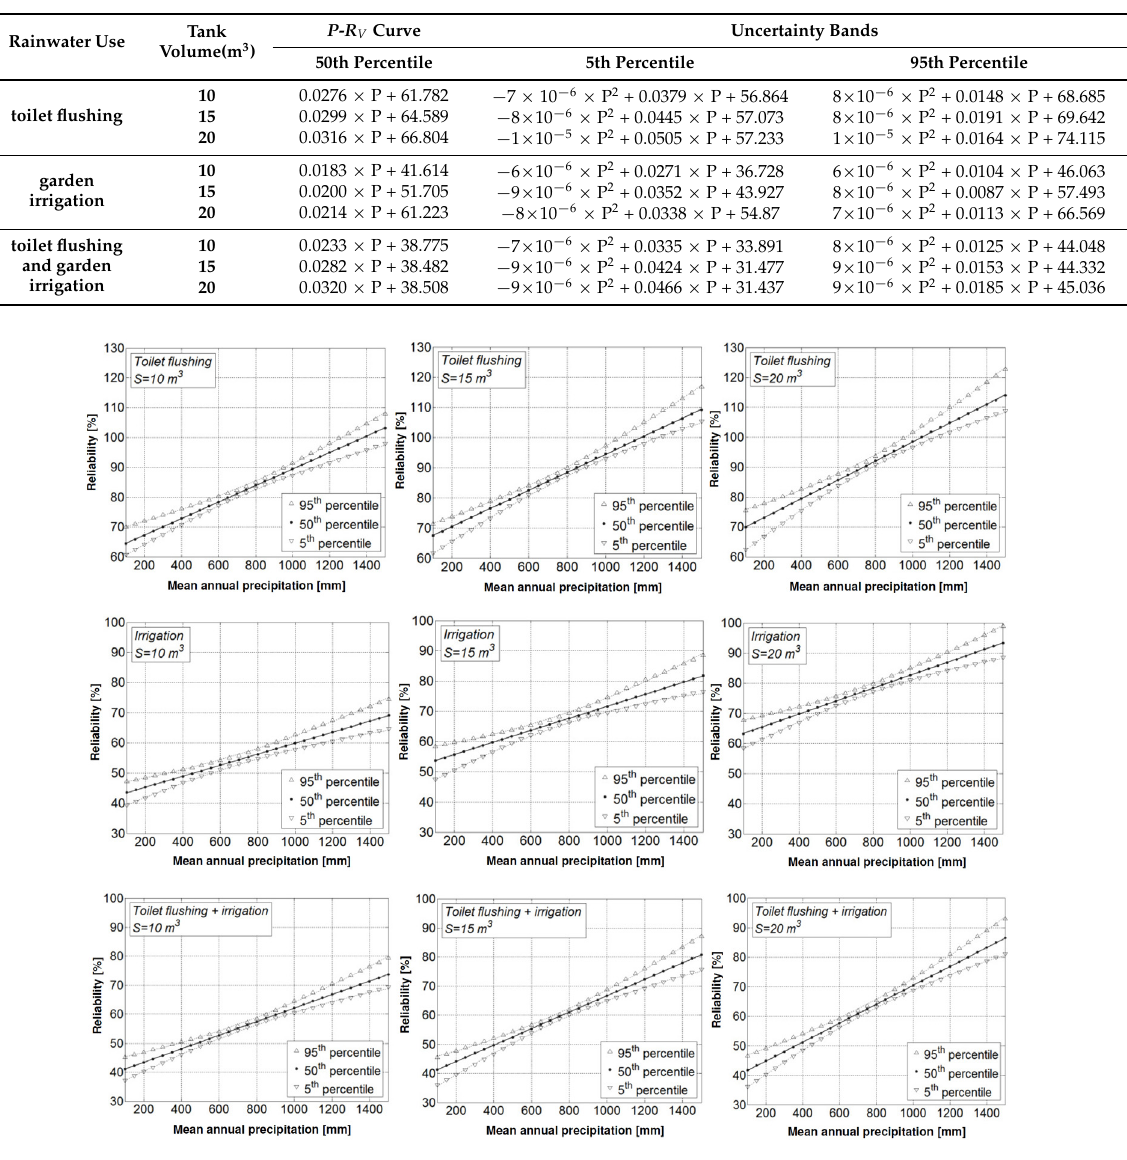
Figure 7. Reliability curves and their uncertainty bands for each uses and analyzed storage volumes.